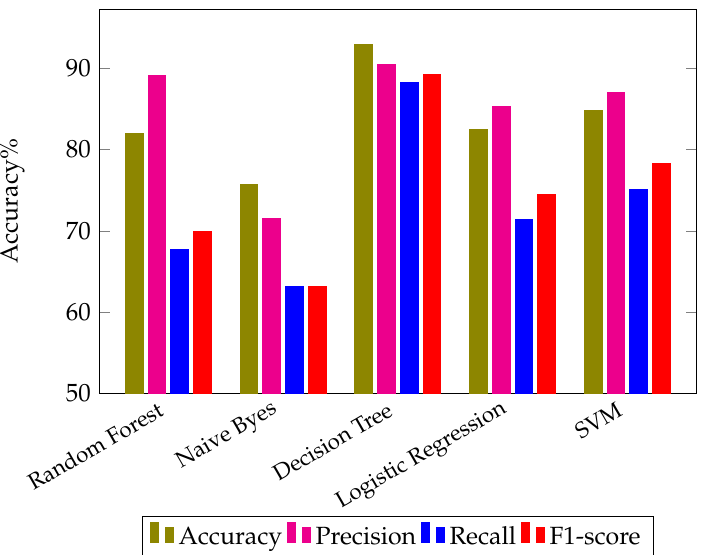
Figure 3. Machine learning Performance on COVID-19 vaccine tweets with sentiment